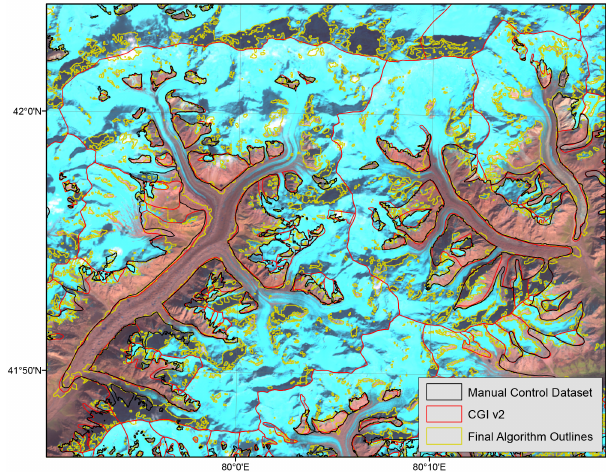
Figure 7. Algorithm outlines (yellow) compared to the control data set (black) and the CGI v2 (red) illustrate high fidelity in overall debris-tongue length between the three data sets, although the algo- rithm outlines exhibit noise along the edges of debris